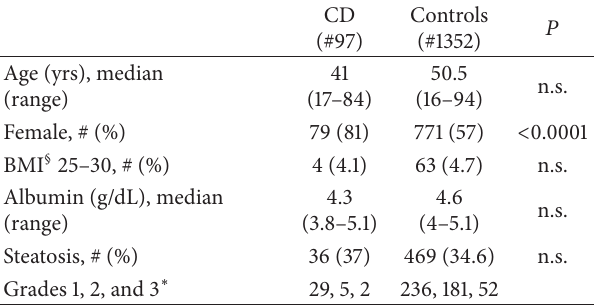
Table 1: Demographic and clinical characteristics in celiac disease (CD) patients and controls.